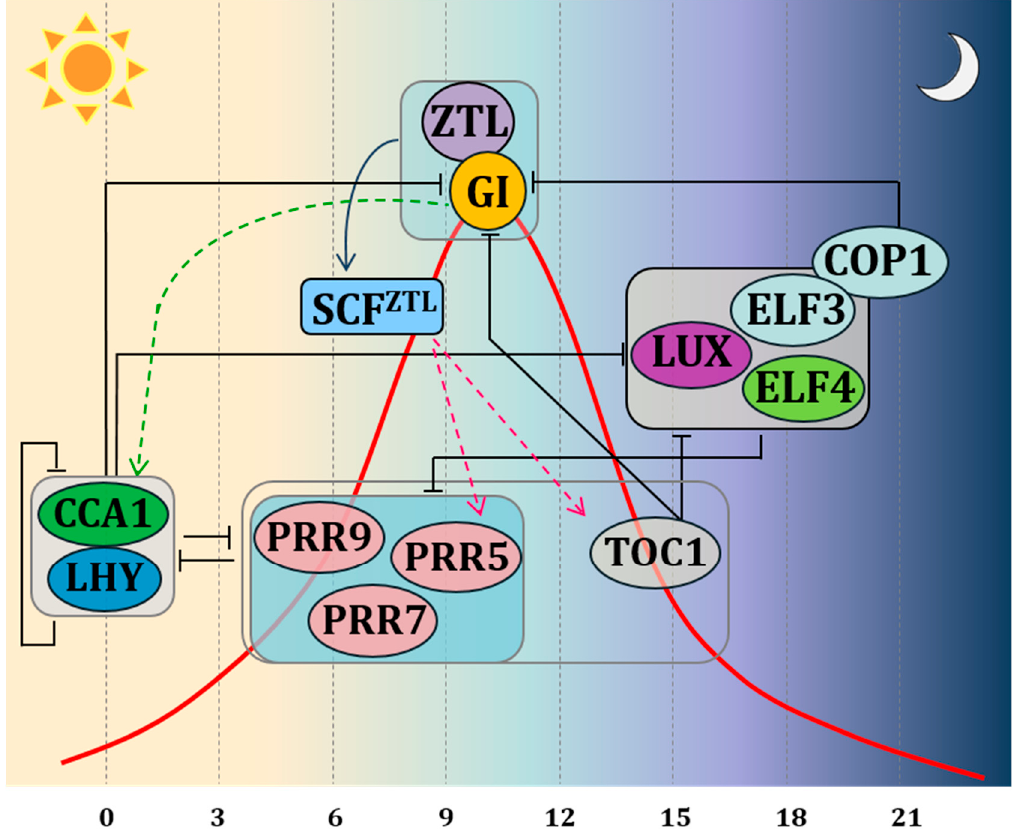
Figure 1. Schematic representation of the clock model indicating interactions by autoregulatory feedback loops via transcriptional and post-translational activation and repression. The clock components are depicted according to their peak-time expression from left to right. Black bars indicate repression. Green arrowheads lines indicate activation of transcription. Fucsia arrowheads lines indicate proteasomal degradation. The red curve represents the expression of GI during the day. TOC1 is protected during the day from ZTL-induced proteasome degradation thanks to the direct protein-protein interaction of GI with ZTL. During the evening, ELF3 promotes the proteasome degradation of GI through its interaction with COP1, thus promoting the ZTL-dependent TOC degradation. Boxes indicate sets of genes acting in coordination. The PRR box: PRR 5,7,9—these proteins are sequentially expressed during the day, and all repress LHY and CCA1; GI-ZTL box—protein-protein interaction leads to ZTL maturation; ELF3-ELF4-LUX complex box—protein complex peaking at